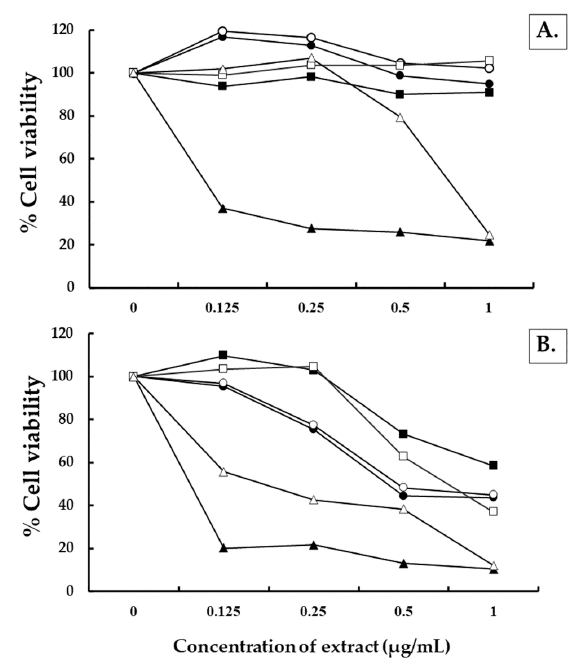
Figure 4. Effects of the extracts of Clausena excavata (essential oil, - ○ -; methanol extract, -●-), Clausena harmandiana (essential oil, -□-; methanol extract, - ■ -) and Murraya koenigii (essential oil, - △ -; methanol extract, - ▲ -) against human lung cancer cells (A549) at 24 h ( A ) and 48 h ( B ).